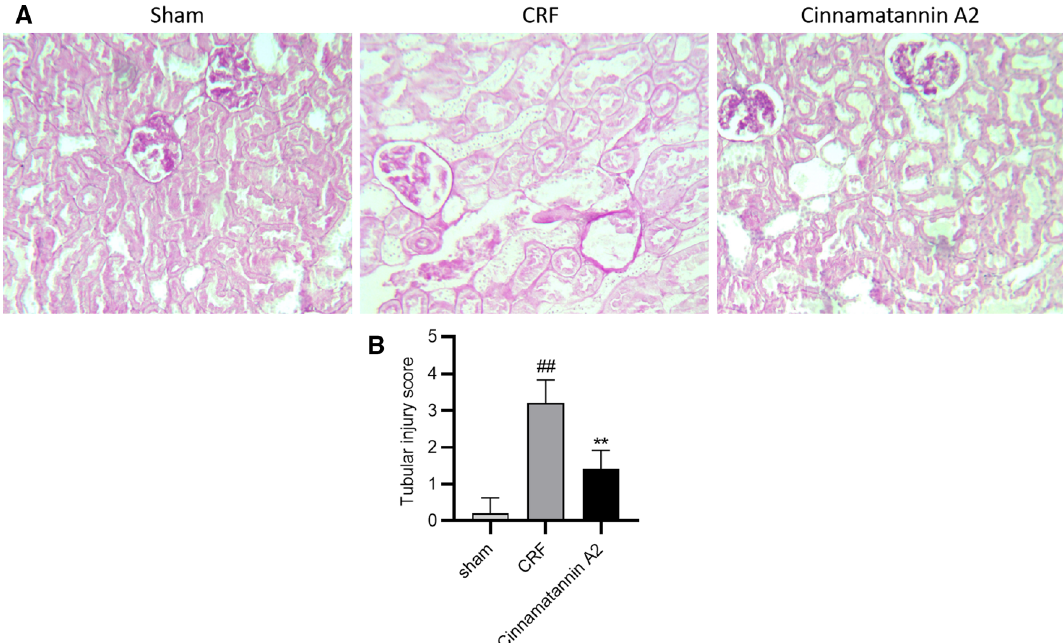
Fig. 7 Effect of Cinnamtannin A2 on the histopathology of kidney tissue of 5/6 nephractomized rats. a PAS staining to the TS of kidney tissue. b Tubular Injury score. Mean SD (n 10); ## p < 0.01 than Sham operated group; **p < 0.01 than CRF ± =